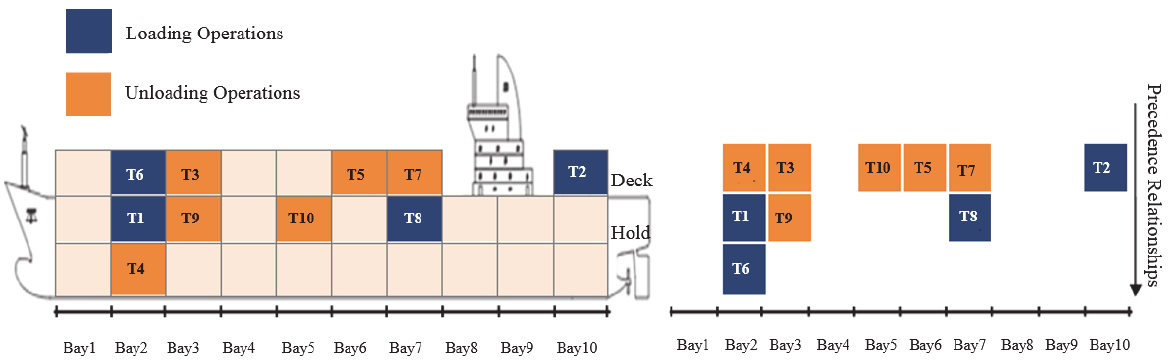
Fig. 1 . Illustration of an instance of the Uncertain QCSP (a) and a simple representation of precedence relationships